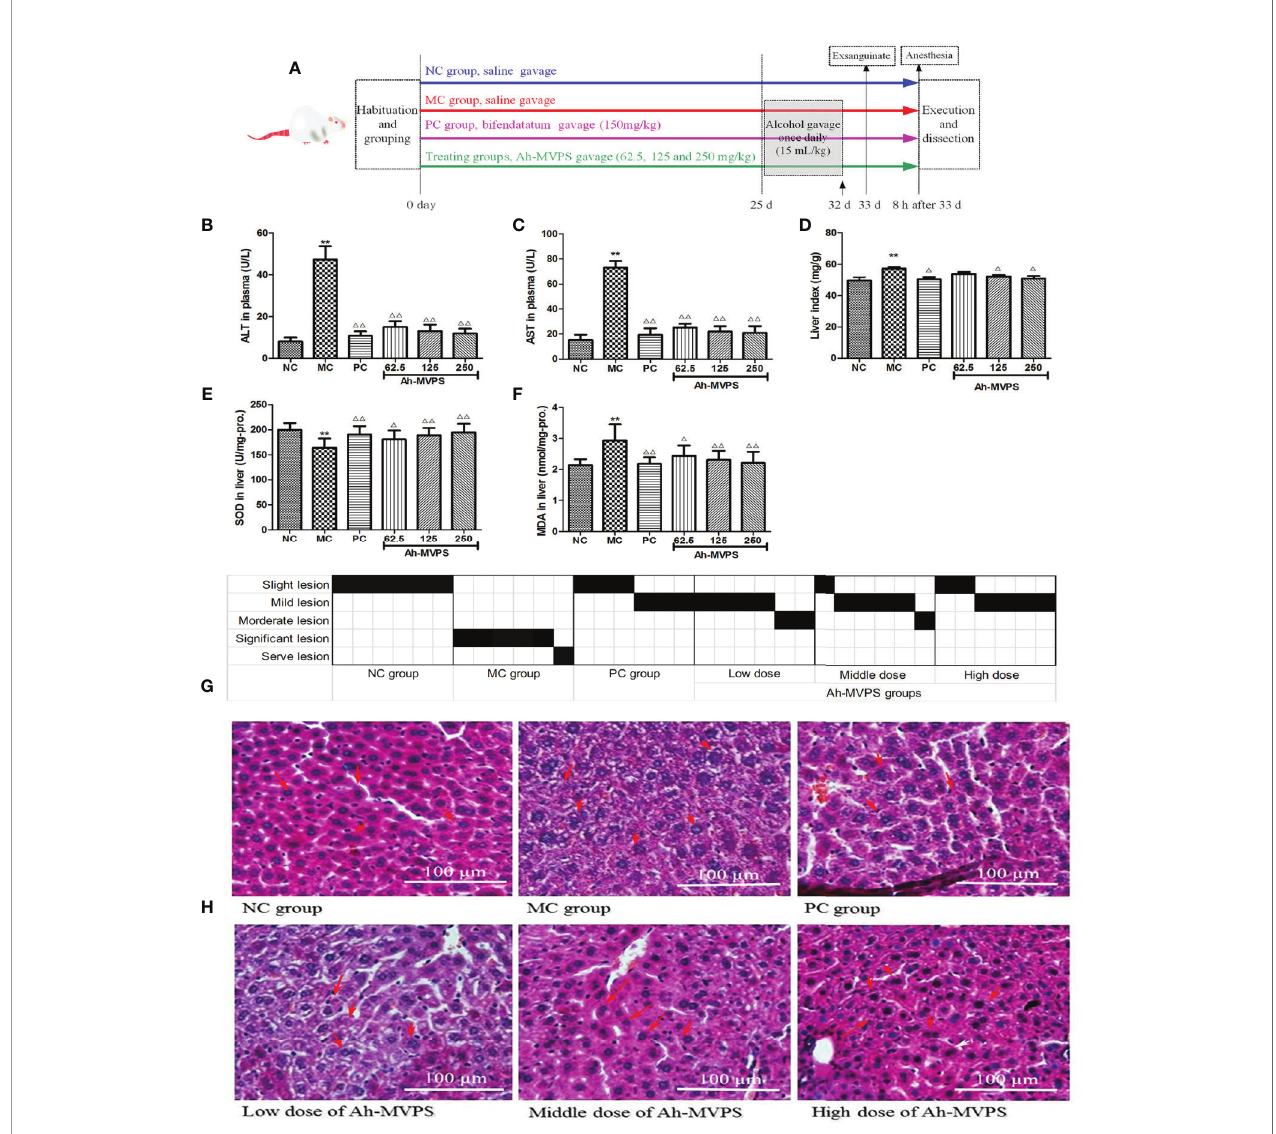
FIGURE 3 | Protective effects of Ah-MVPS on the injury of mouse liver induced by alcohol. The time protocols of animal disease model setting and administration (A) . Comparative analysis of ALT (serum alanine aminotransferase, B ), AST (aspartate transaminase, C ), LI (liver index, D ), SOD (superoxide dismutase, E ), and MDA (malondialdehyde, F ) of mice in each group, **P < 0.01 vs. normal control (NC) group, D / P < 0.05, DD P < 0.01 vs. model control (MC) group. Recording table of pathological scoring (G) , and typical H&E section images (H) of the mouse liver tissues (400-fold magni fi cation); red arrows indicate normal and/or injured